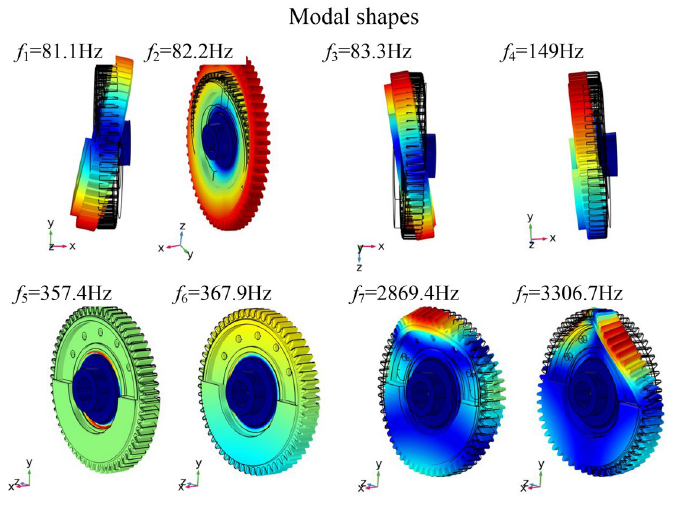
Table 6. The modal modes corresponding to different natural frequencies are consistent, and the first eight modes are shown in Fig 9. Table 6 shows that with increasing modal order, the natural frequencies of the balanced gear and rigid gear gradually increase. Fig 9 shows that as the stiffness of the rubber ring con- tinues to increase, the natural frequencies of the balanced gear continue to increase, but it was far smaller than the rigid gear, so the design of the balanced vibration damping structure is reasonable. To analyze the influence of the stiffness and damping characteristics of the rubber ring on the gear meshing characteristics and vibration, the assembly model of the optimized balanced gear meshing transmission was established using Solidworks software and imported into Adams to verify its meshing characteristics and virbration reduction characteristics.